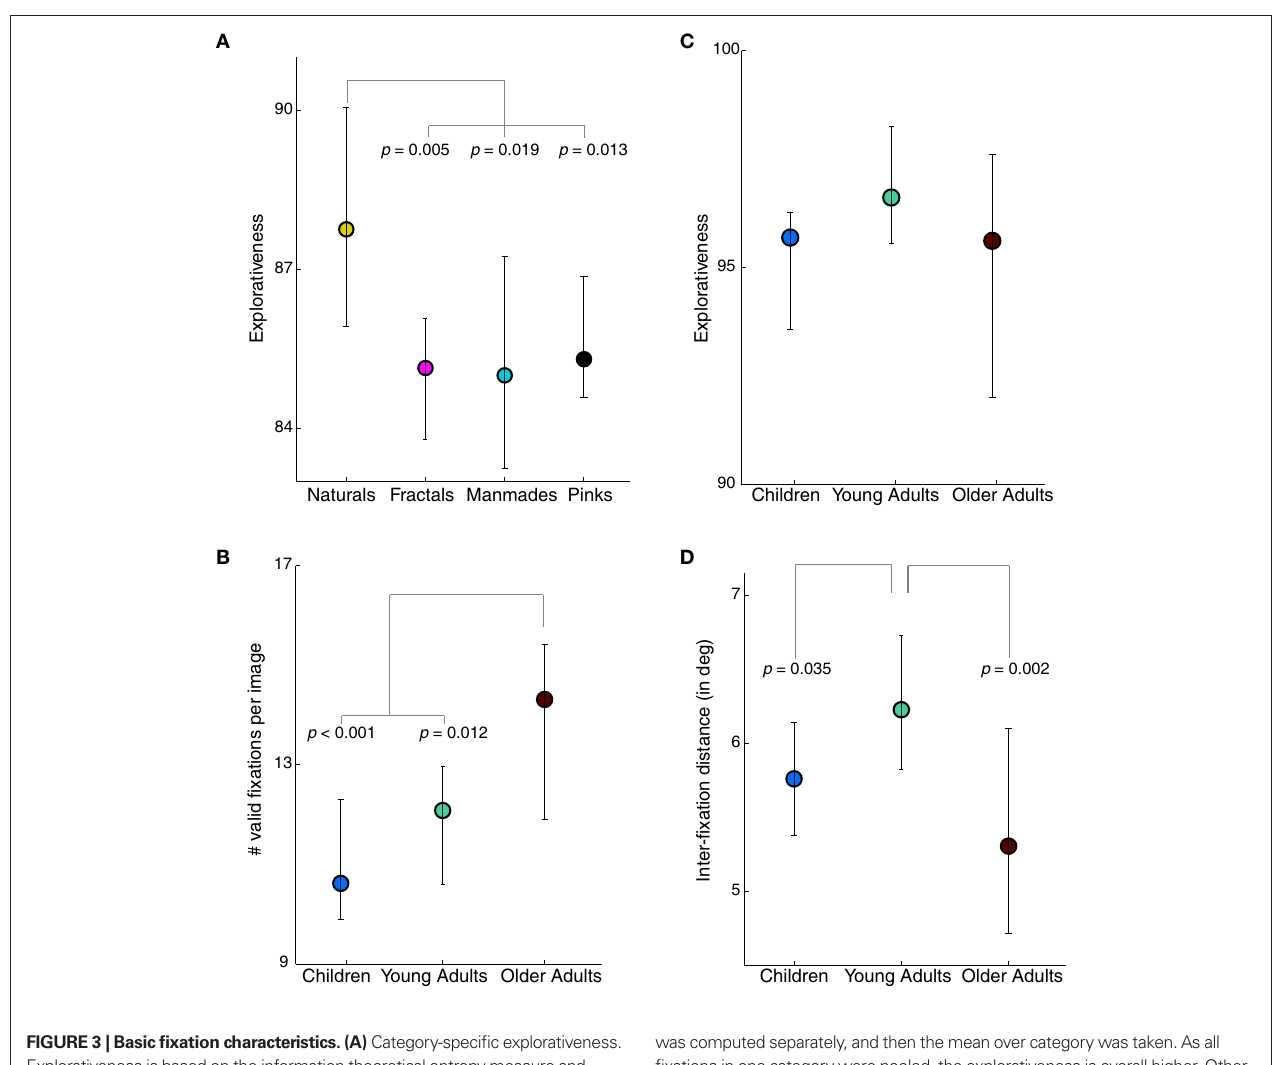
Figure 3 | Basic fixation characteristics. (A) Category-specific explorativeness. Explorativeness is based on the information theoretical entropy measure and quantifies how actively a participant viewed the images. For each image and age group, explorativeness was computed separately, and then the mean over age was taken. Circles show category medians, and error bars denote 95% confidence intervals (CIs). The branching lines connect significantly different ( p < 0.05) categories determined by permutation sampling and exact p -values down to p = 0.001 can be seen next to the branches. (B) Age-specific explorativeness. For each subject and all categories but pinks , explorativeness